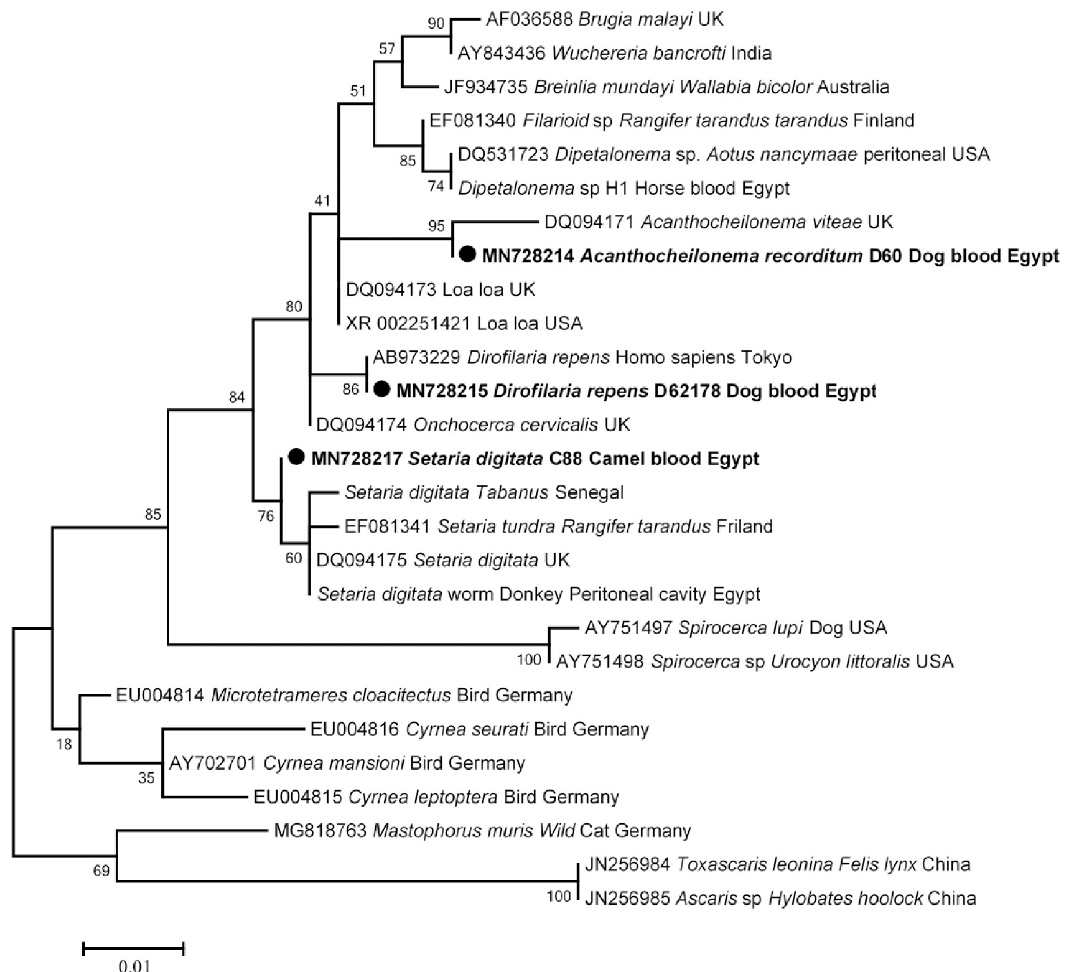
Fig 7. 18S rRNA based phylogenetic analysis of genotypes identified in this study. Phylogenetic tree highlighting the position of Filaria sp. in the present study ( Bold ) related to other Filaria sp. available in GenBank. The sequence of 18S rRNA were aligned using CLUSTAL W and phylogenetic inferences were constructed in MEGA X using Maximum Likelihood based on Tamura-Nei Model for nucleotide sequences with 500 bootstrap replicates. There was a total of 1110 positions in the final dataset. The scale bar represents a 10% nucleotide sequence